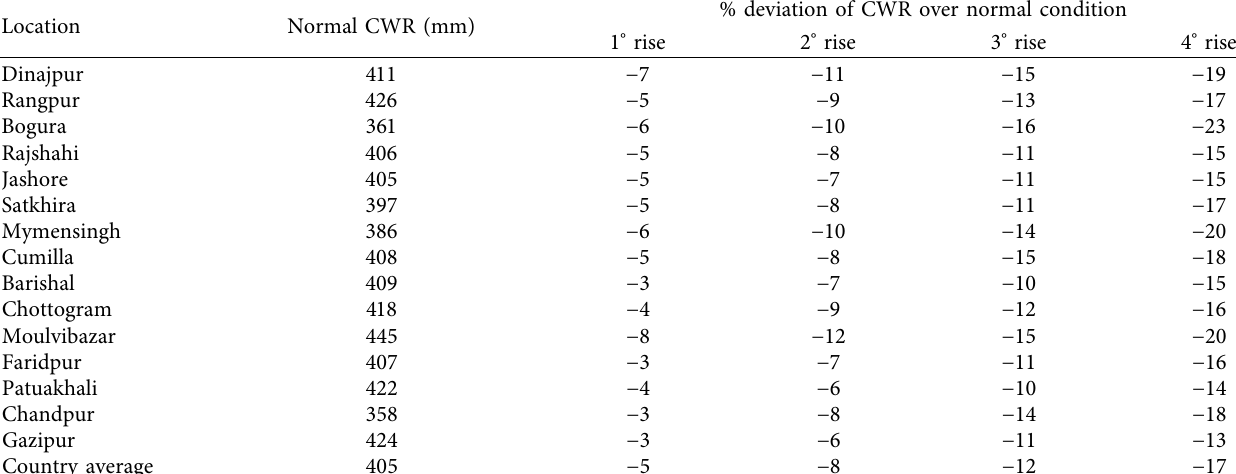
Table 8: Change of crop water requirement (CWR) to temperature rise in Bangladesh.